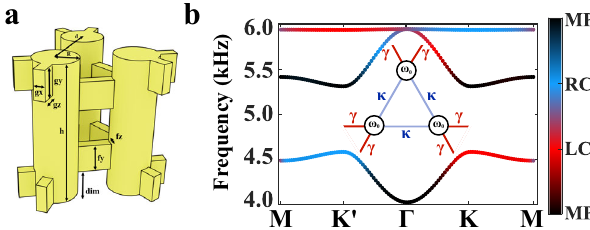
Fig. 2 | The transition between linear polarization to circular polarization for acousticmodesinkagomelatticewithsyntheticdegreesoffreedom.a Unitcell of the acoustic kagome crystal with in-plane synthetic pseudo-spin de fi ned as cir- cularly polarized rotation of acoustic pressure fi eld within the cell (phase shift of 2 π /3 between resonators). b First-principles acoustic band structure of the crystal with color indicating the degree of RCP, LCP, and inphase (IP)polarizations. Color bar data is calculated by fi rst building a normalized wavefunction of the pressure amplitude at the antinode of each resonator in the trimer unit cell such that (cid:5) (cid:4) ð k Þ ∣ u = P 1 , P 2 , P 3 n